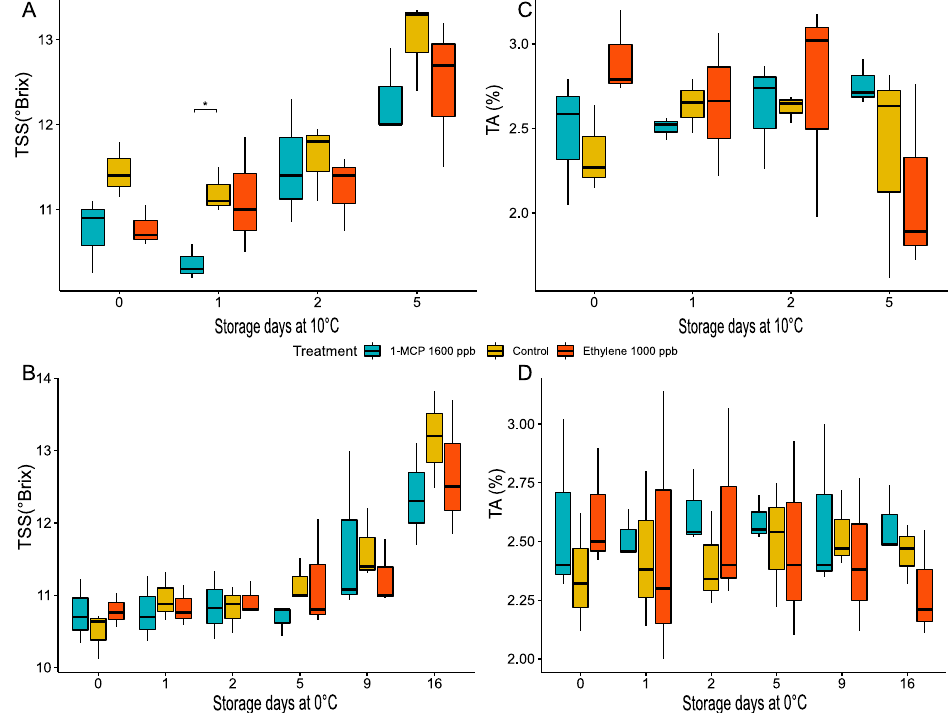
Figure 11. The total soluble solids and titratable acidity of raspberry ( Rubus idaeus ‘Heritage’) fruit during treatment with ethylene and 1-methyl cyclopropane (1-MCP). The storage assay was performed at the W stage of the raspberry fruit and stored for 5 and 16 days at 10 °C ( A , C ) and 0 °C ( B , D ), respectively. Total soluble solids (TSS, °Brix) ( A , B ) and titratable acidity (TA, %) ( C , D ) were determined for ethylene and 1-MCP-treated fruits and controls. Data represent the means ± S.D. from five sample units (each containing ten fruits). Asterisks indicate significant differences between treatments at the same storage time ( p ≤ 0.05). Boxplots show each group’s distribution (treatment), and the black line (central value in the box) signs the median value. Points out of the boxplots show outlier values.